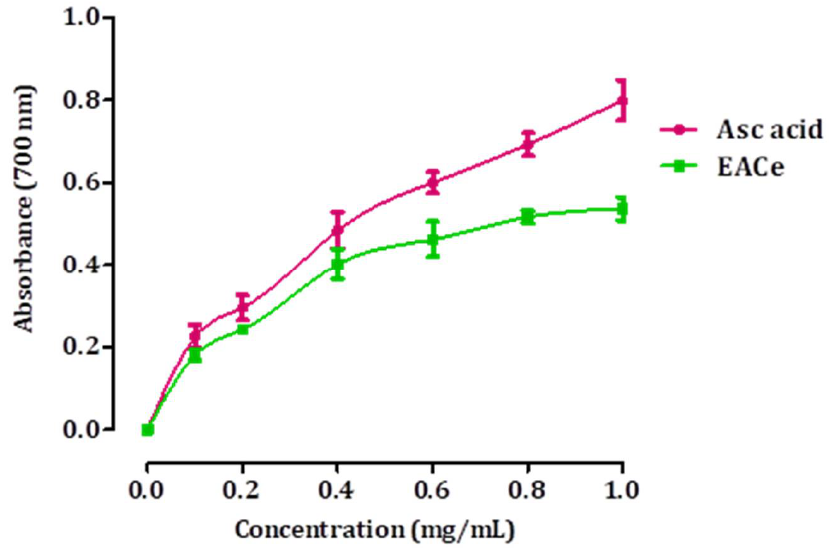
Figure 3. Reducing power of EACe at different concentrations. Each value represents a mean ± SD ( n = 3).